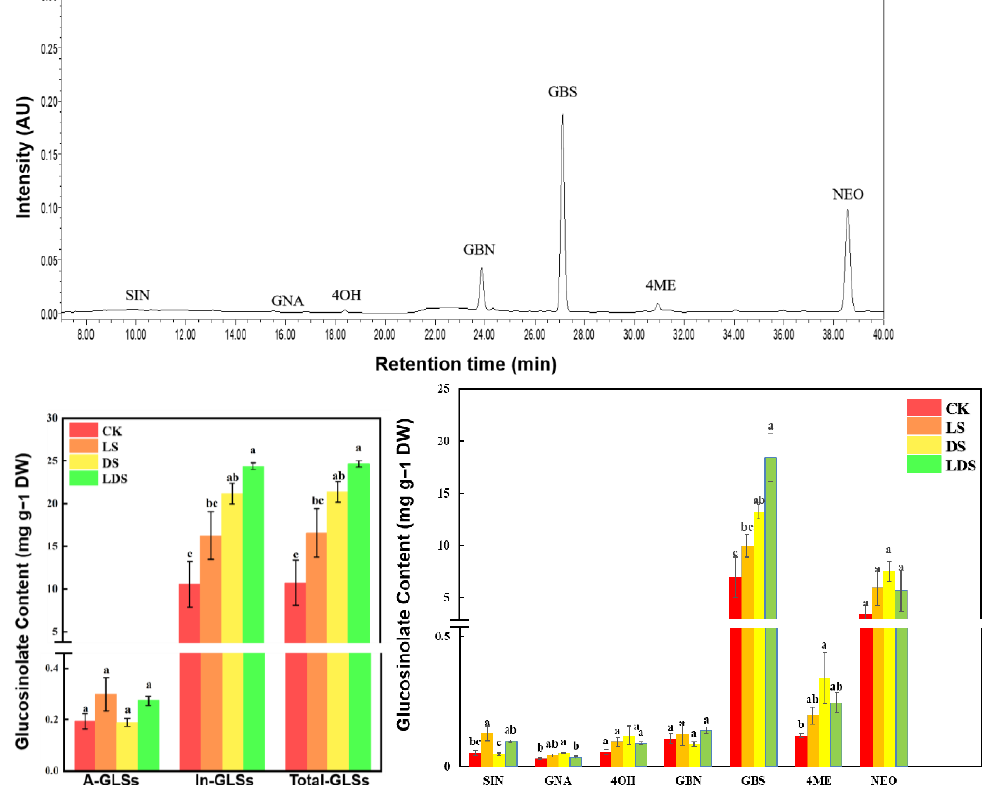
Figure 1. Glucosinolate content of kale under different UV-A treatments. Different lowercase letters reveal significant differences ( p < 0.05), according to Duncan’s test. Vertical bars indicate the standard margin of error. “LS” = Light-UVA Supplementation, “DS” = Dark-UVA Supplementation, “LDS” = Light/Dark-UVA Supplementation. SIN = sinigrin, GNA = gluconapin, 4OH = 4- hydroxyglucobrassicin, GBS = glucobrassicin, GBN = glucobrassicanapin, NEO = neoglucobrassicin, 4ME = 4-methoxyglucobrassicin, In-GLSs = Indolic Glucosinolate, A-GLSs = Aliphatic Glucosinolates. UV-A supplementation in different photoperiods (LS, DS, and LDS) markedly boosted the content of indolic GLSs in kale, with 54.12%, 100.66%, and 131.09%, respectively. Among them, DS treatment indicated the highest 4ME content by ~183.33%, while LDS treatment revealed the highest GBS content by ~165.13%. LS yielded higher SIN content (140%) and DS exerted higher GNA content (80%), while total aliphatic GLSs content remained no distinct